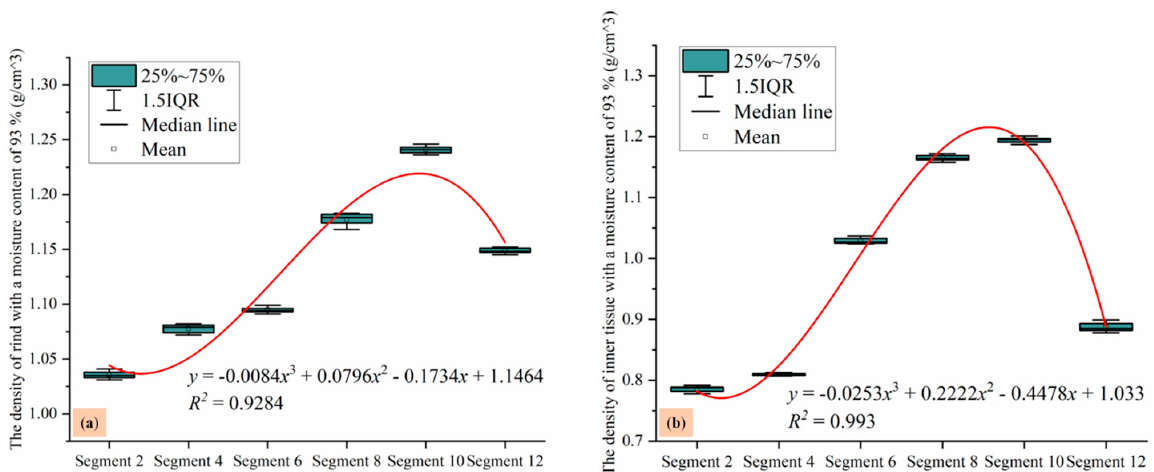
Figure 9. The relationship between the density of bunch stalks with a moisture content of 93% and the segments. ( a ) The relationship between the density of rind and the segments; ( b ) the relationship between the density of inner tissue and the segments.